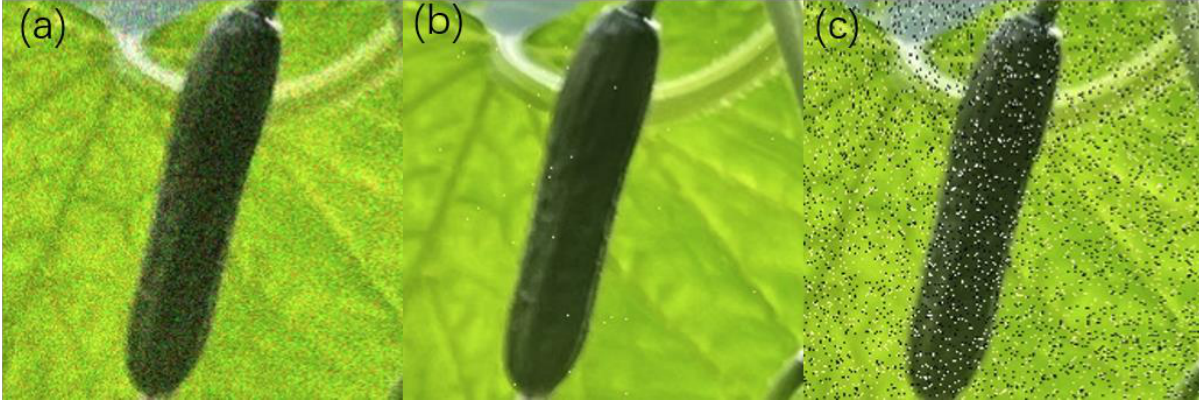
Figure 3. Different types of noise applied to cucumber images: ( a ) Gaussian noise; ( b ) random noise; and ( c ) salt and pepper noise.